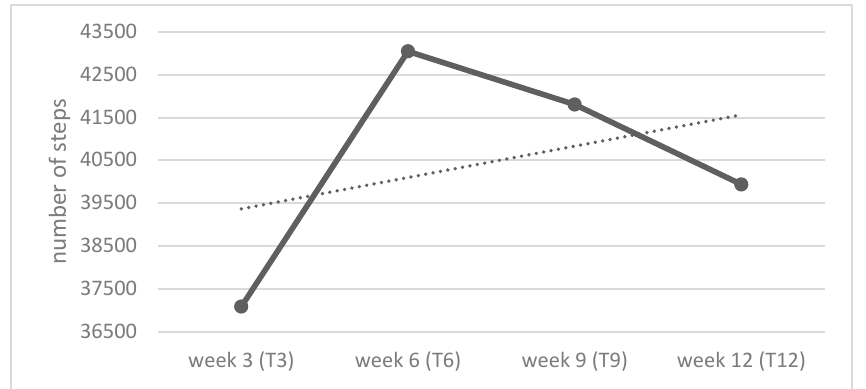
Figure 2. Total average number of steps per week at four time points (n = 12). Note: Out of 13 partici- pants who completed the study, 12 provided the information on the daily steps walked during the four selected